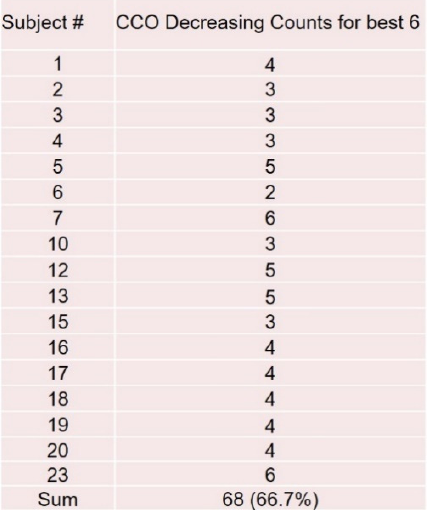
Figure 16. Table illustrating the “best of 6” screening of the 17 participants after removing the outliers. The second column represents the number of data blocks with CCO decreasing.